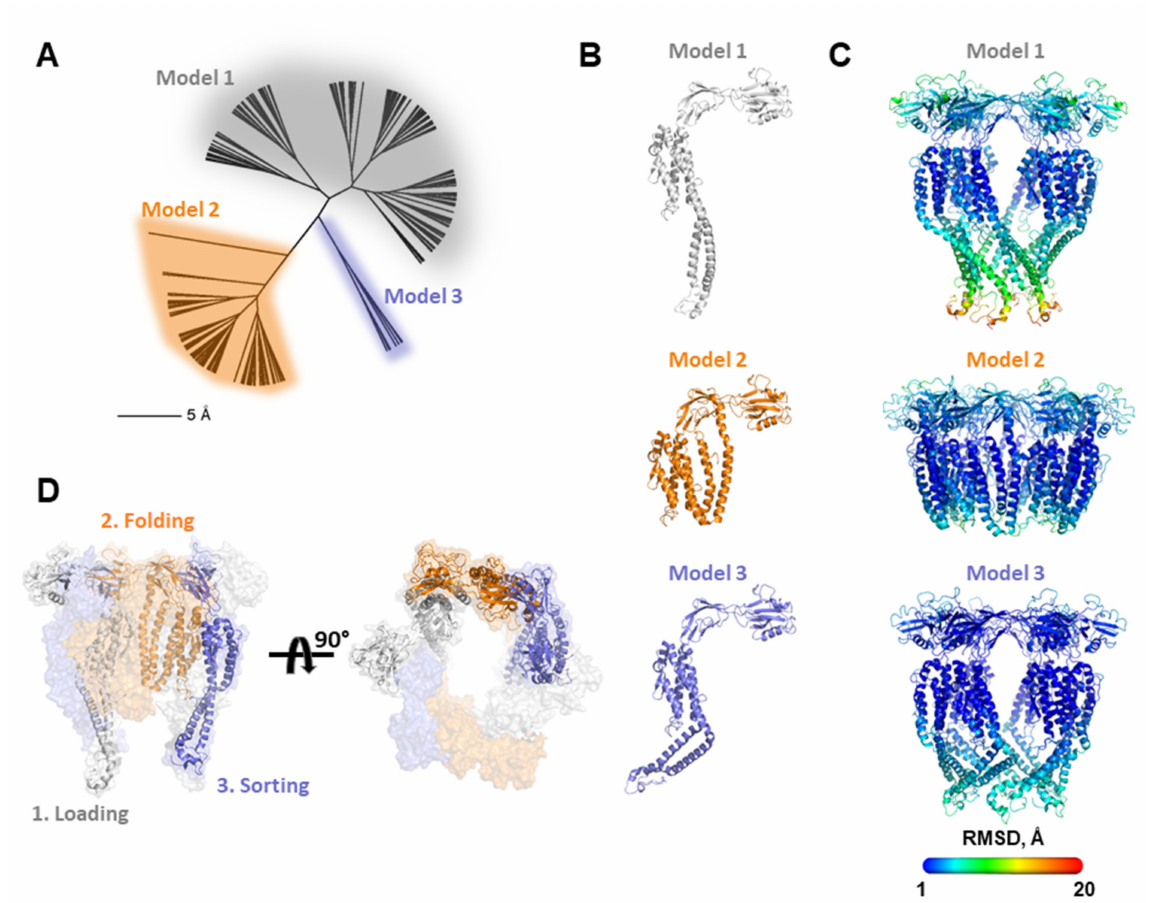
Figure 6. Molecular modeling of FliD conformations. ( A ) Conformational cluster analysis of FliD molecular